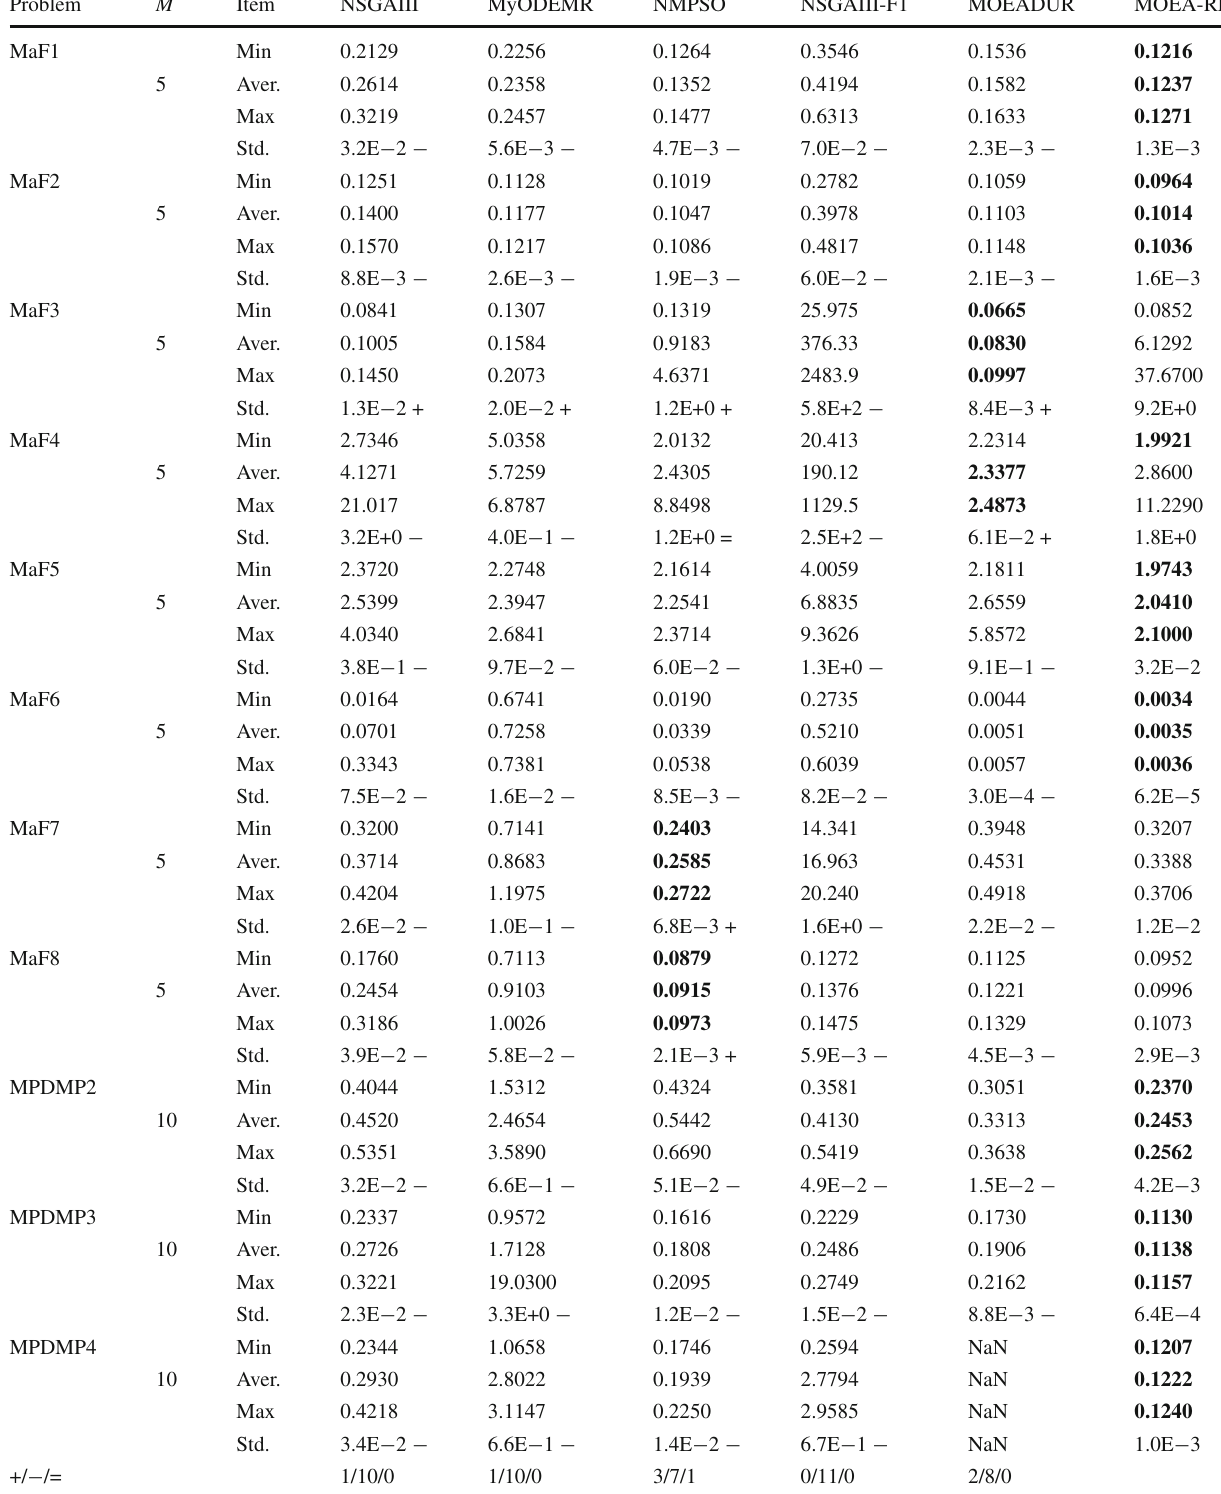
Table 3 The IGD values (best, medium, and worst) on MaFs and MPDMPs